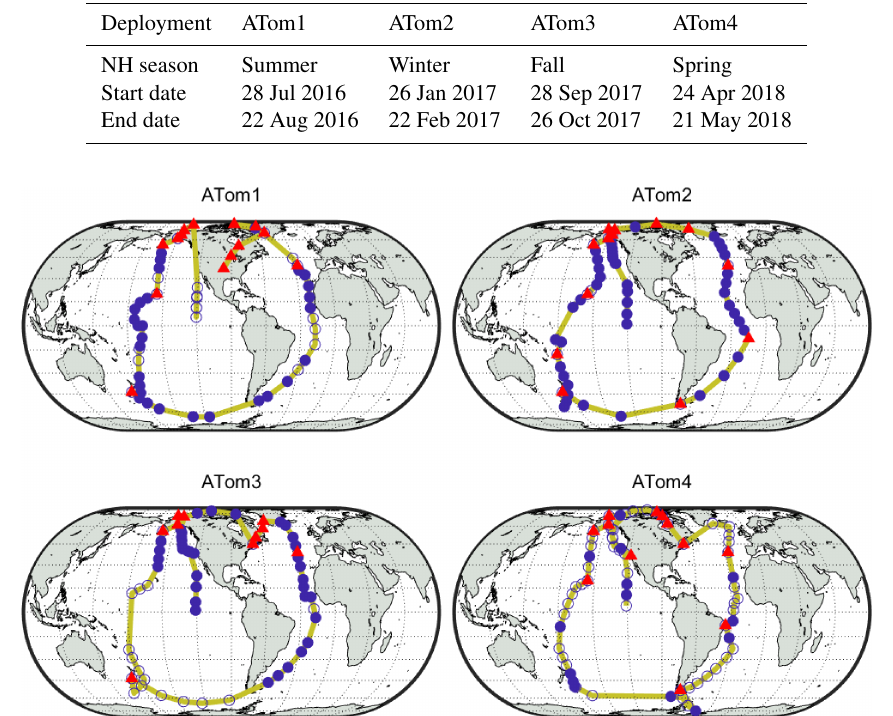
Figure 1. Global ATom tracks (yellow lines) with indicators for the periods during which the DC-8 dipped into the boundary layer. Filled blue circles indicate points used for analysis, filled red triangles indicate dips when over land, and unfilled blue circles indicate dips not used for analysis due to instrument calibrations or